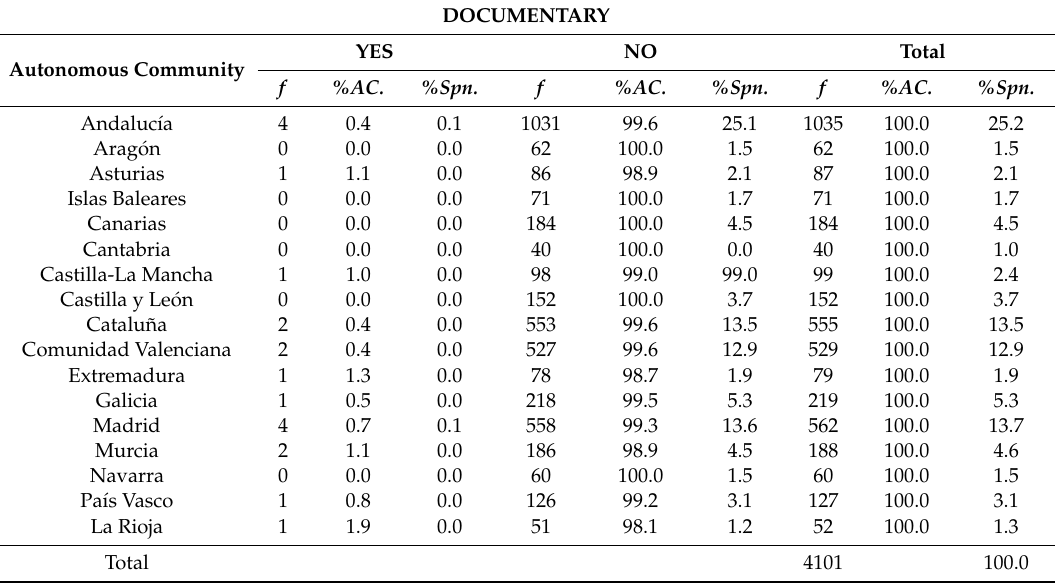
Table 5. Percentages and frequencies of documentary cinema seen by teacher (cid:48) s degree students, according to the Autonomous Community.